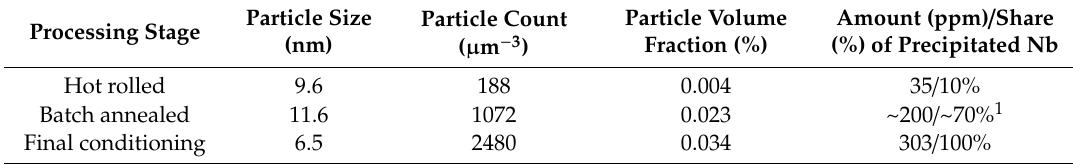
Table 3. Quantitative evaluation of Nb precipitates at various processing stages (average